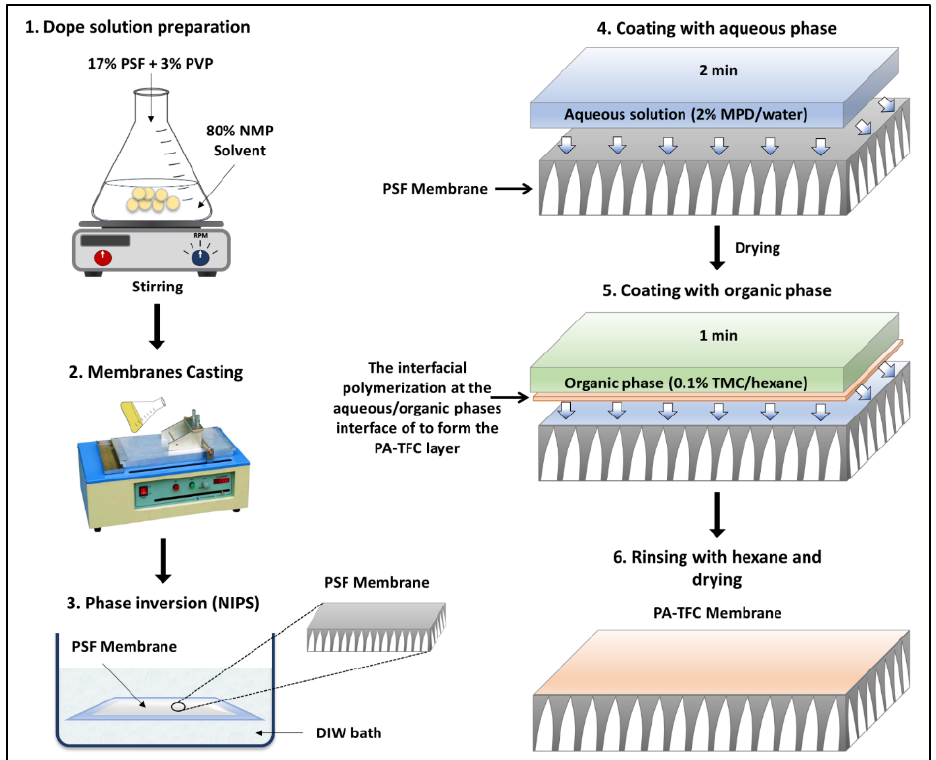
Figure 2. Schematic illustration for the phase inversion and interfacial polymerization approaches used for the TFC membranes fabrication. Table 1. PSF and TFC prepared membrane layers used in this work.